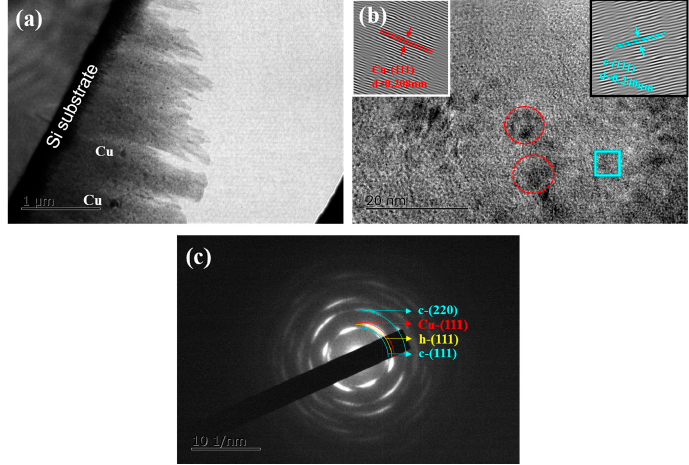
Figure 4. ( a ) TEM, ( b ) SAED pattern, and ( c ) HR-TEM observations of VCN–13.2 at.% Cu film.